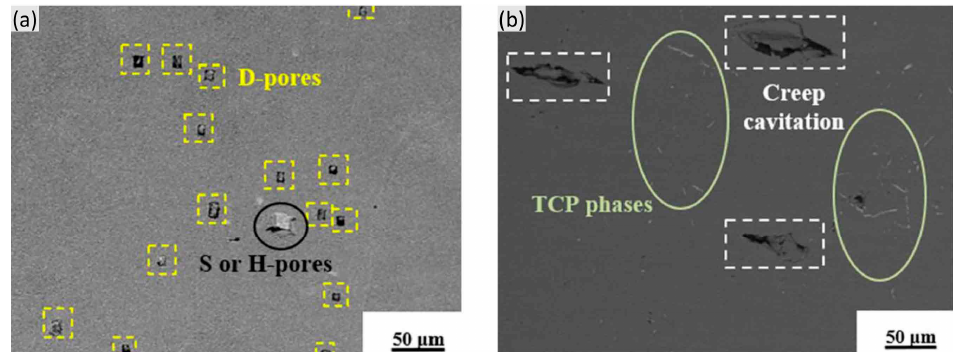
Figure 21. Microstructures in the crept specimen (at 1120 °C/137 MPa) of a Re-containing single crystal superalloy after thermal exposure of 1100 °C/500 h showing ( a ) the distribution of D-pores, and all of them marked by a yellow square dotted line, and ( b ) the crack distribution near the fracture surface, illustrating that the TCP phase does not cause crack directly [63].